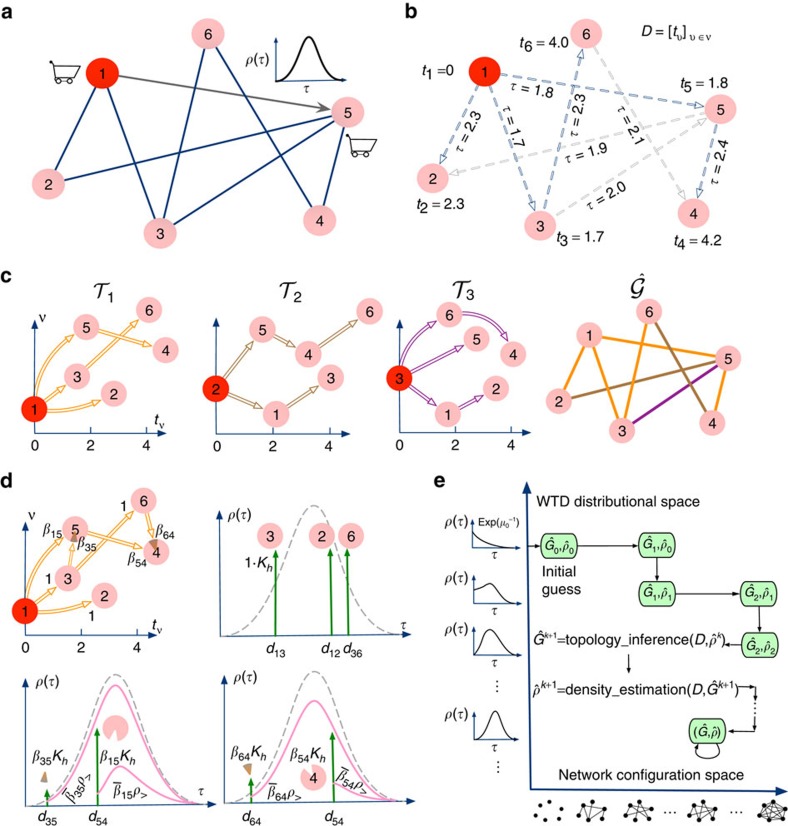
Schematic representation of our inferential framework.(a) The STN tuple  to be inferred which confines the underlying diffusion process, both spatially and temporally. Specifically, a diffusion cascade originated by any source node (red circle) can only proceed on the time-aggregated graph , and relay delay of diffusion along any network link (green arrow) is a random variable τ (called waiting time) with the corresponding distribution denoted by WTD ρ(τ). (b) A simulated diffusion cascade using our generative model with realized waiting times attached to network links. Here, DAT data  are obtained from first-arrival observations of the diffusion cascade, with each entry tv equal to the length of the shortest diffusion path (blue dashed arrow) connecting nodes s* and v. The dashed arrows highlight that the waiting times are unobservable in our problem settings. (c) An illustrative result of topology inference using multiple diffusion cascades. Intuitively, the network topology  can be recovered by uniting the realized (or inferred) diffusion paths,  (). Here,  denotes the underlying diffusion tree associated with the observed cascade, which is inferable from diffusion data as a spanning tree  with maximum link weights βuv (called branching coefficient, see definition below). (d) Kernel density estimation for WTD ρ(τ) using  as incomplete observations of underlying waiting times. For brevity, we adopt Dirac delta kernel function Kh(τ)=δ(τ). The sector located at each node v represents its associated branching coefficients, each βuv defining the probability that an upstream neighbouring node  spreads the information to node v in a specific cascade. Thus the self-consistent estimator  simply sums over all observed cascades (only one is shown here) Dirac deltas of amplitude βuv placed at the TDOAs, duv=tv−tu, as well as  itself truncated above duv and then renormalized to . The first term corresponds to the contribution from link (u,v) as a diffusion branch leading to the tight constraint τuv=duv with probability βuv, and the second from link (u,v) as a chord having the censored waiting time τuv>duv with the complementary probability . (e) The coordinate-ascent implementation of our inferential method. The overall procedure is initialized with a first guess  for the WTD, and alternates until convergence between the topology inference and density estimation steps using observed diffusion data and the most recent estimates. Additional algorithmic details can be found in Supplementary Note 7.